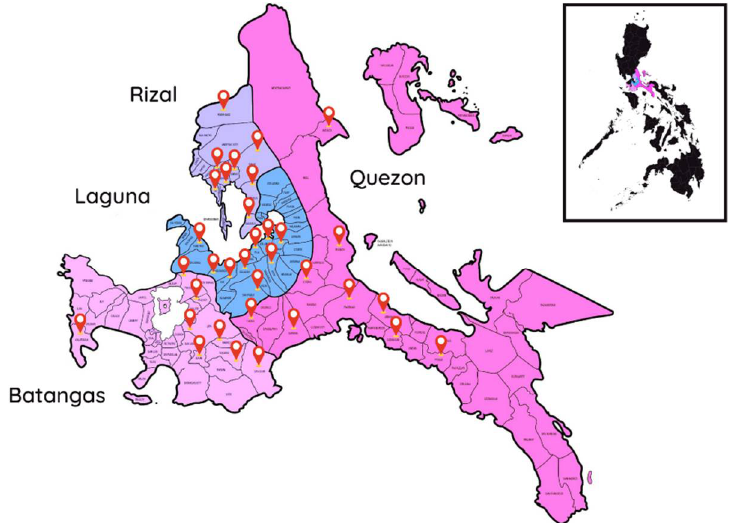
Figure 1. Map showing the four provinces of Region 4A (CALABARZON) included in the study, namely Laguna, Batangas, Rizal, and Quezon. Red pins mark the municipalities where the blood samples were collected. The labels and smaller map were placed using online graphic design platform Canva (https://www.canva.com/; accessed on 16 February 2022).